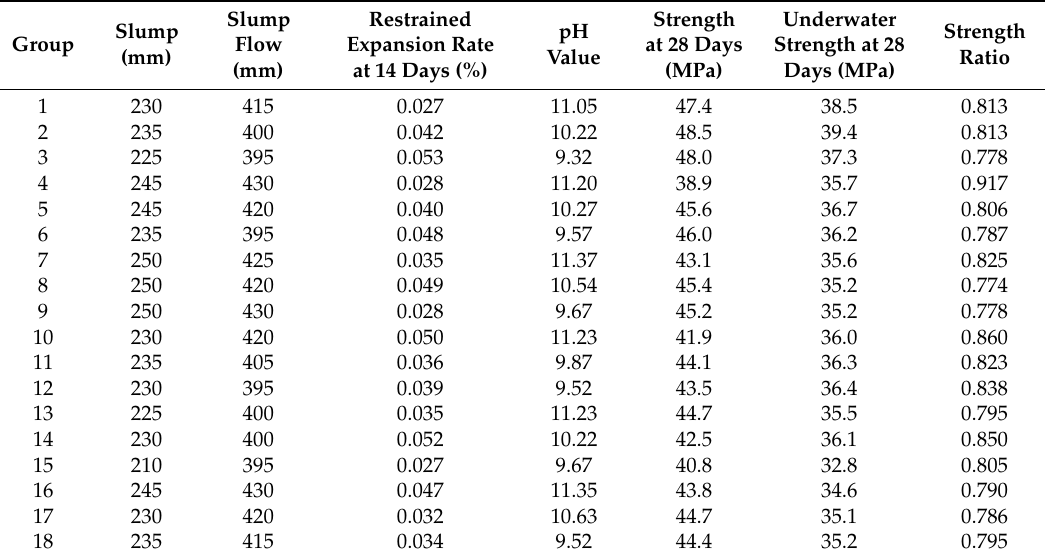
Table 14. Orthogonal test